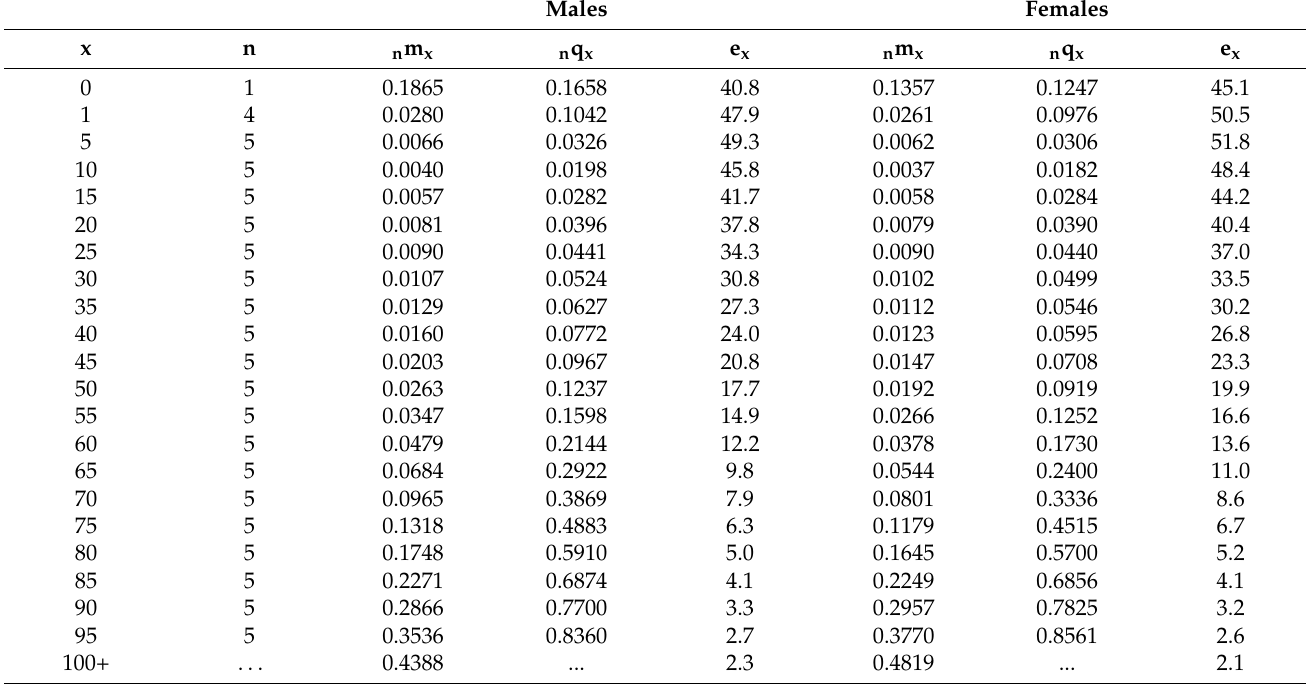
Table A4. Epirus